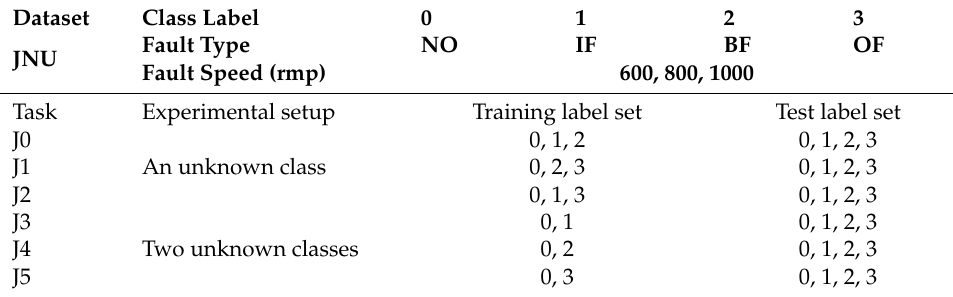
Table 3. The information of the JNU and specific task settings.